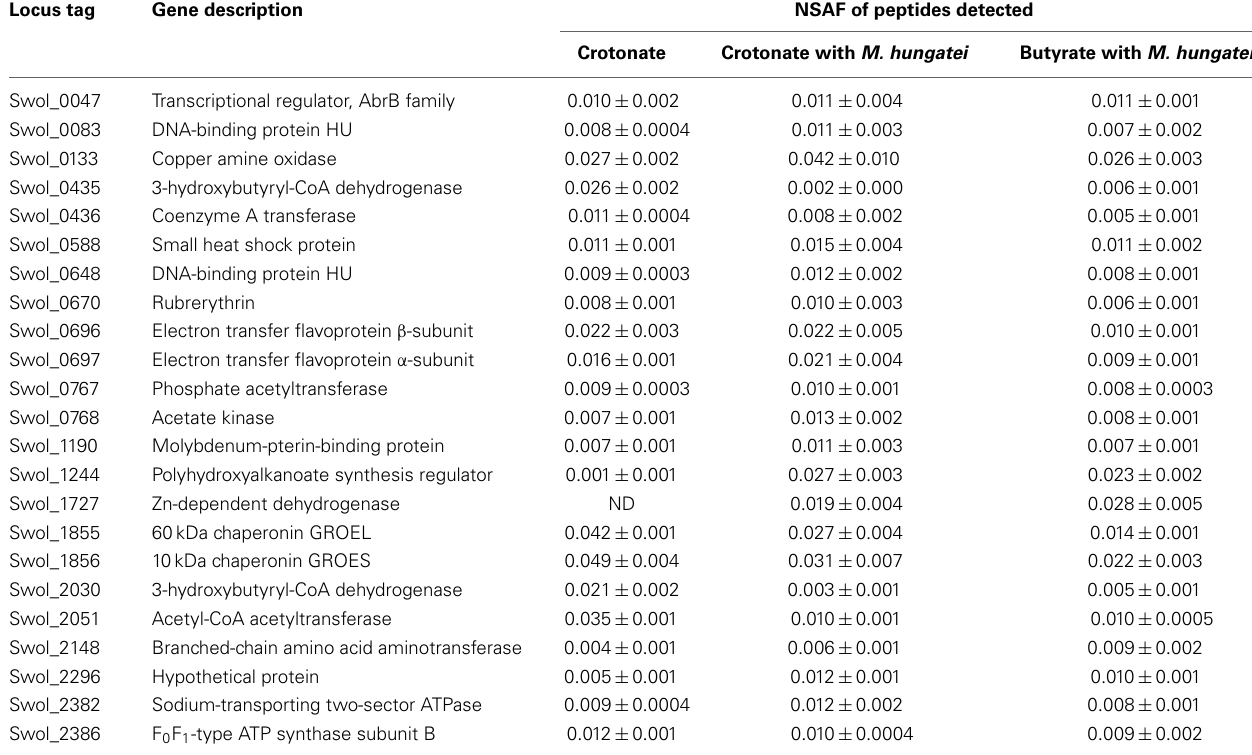
Table 1 | The most abundant peptides detected in each condition. Locus